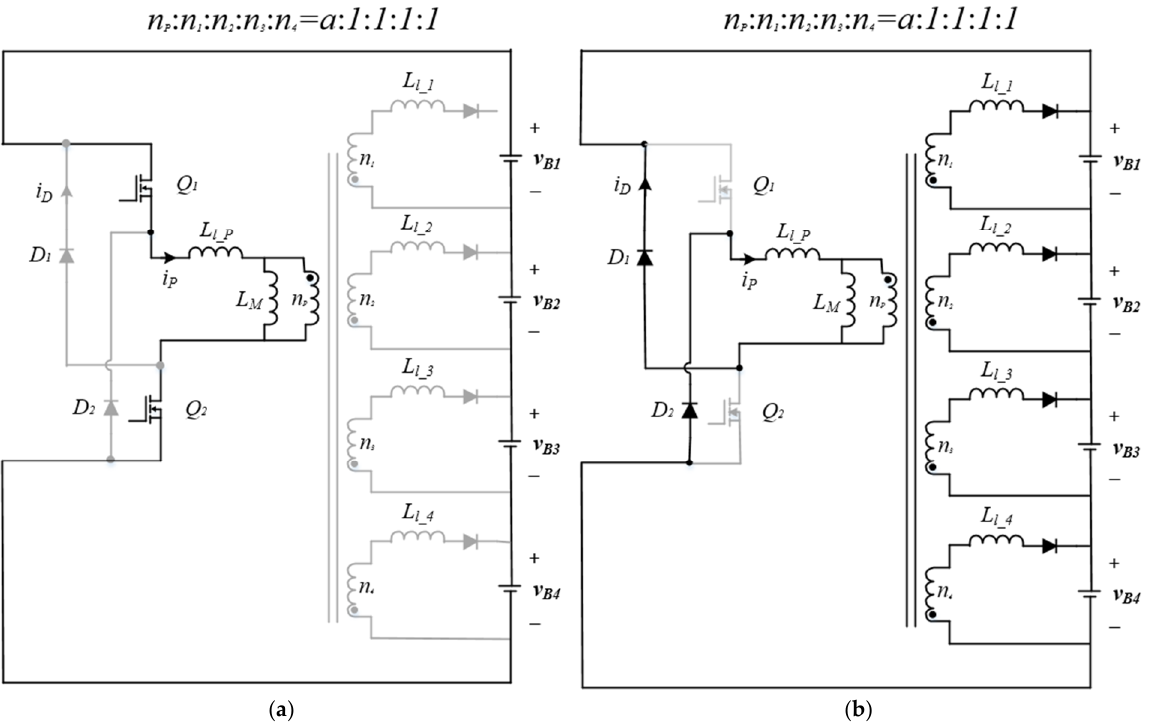
Figure 6. Operation modes of cell − balancing circuit: ( a ) switch on and ( b ) switch off. Cell voltage balancing control starts with a transfer of transformer energy to the secondary cell stage when the converter switches Q 1 and Q 2 are off. Therefore, the energy accumulated in the transformer during the switch-on operation is transferred to the cell stage through the transformer along with the current flowing along the converter